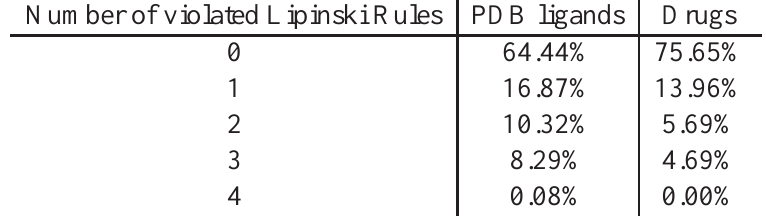
Table 2: Percentage of PDB ligands and drugs violating certain numbers of Lipinski